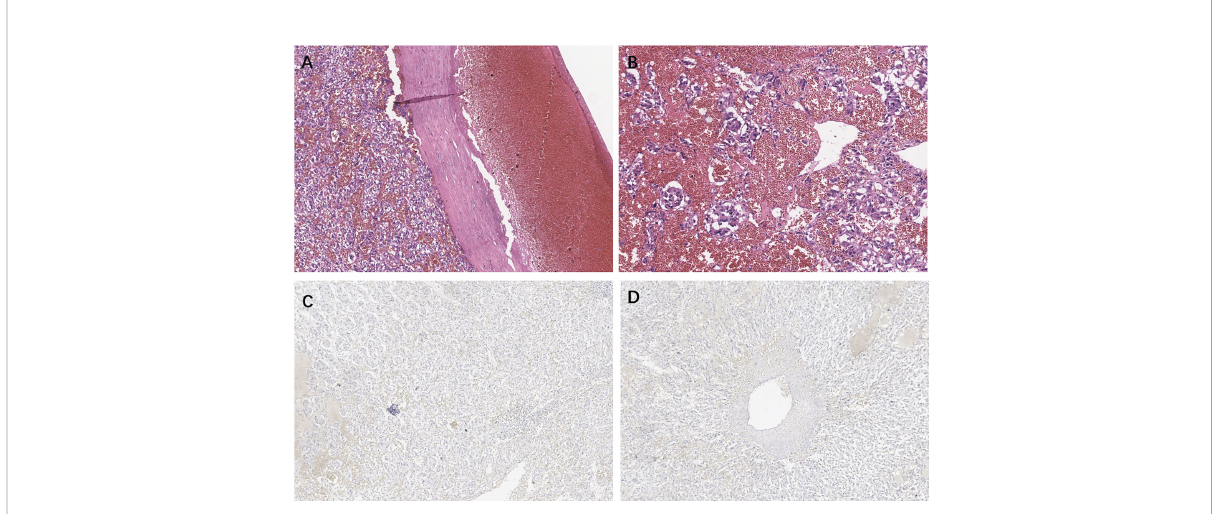
FIGURE 2 H&E staining in (A) ×10 view and (B) ×40 view. (C, D) CD56 staining immunohistochemistry of the